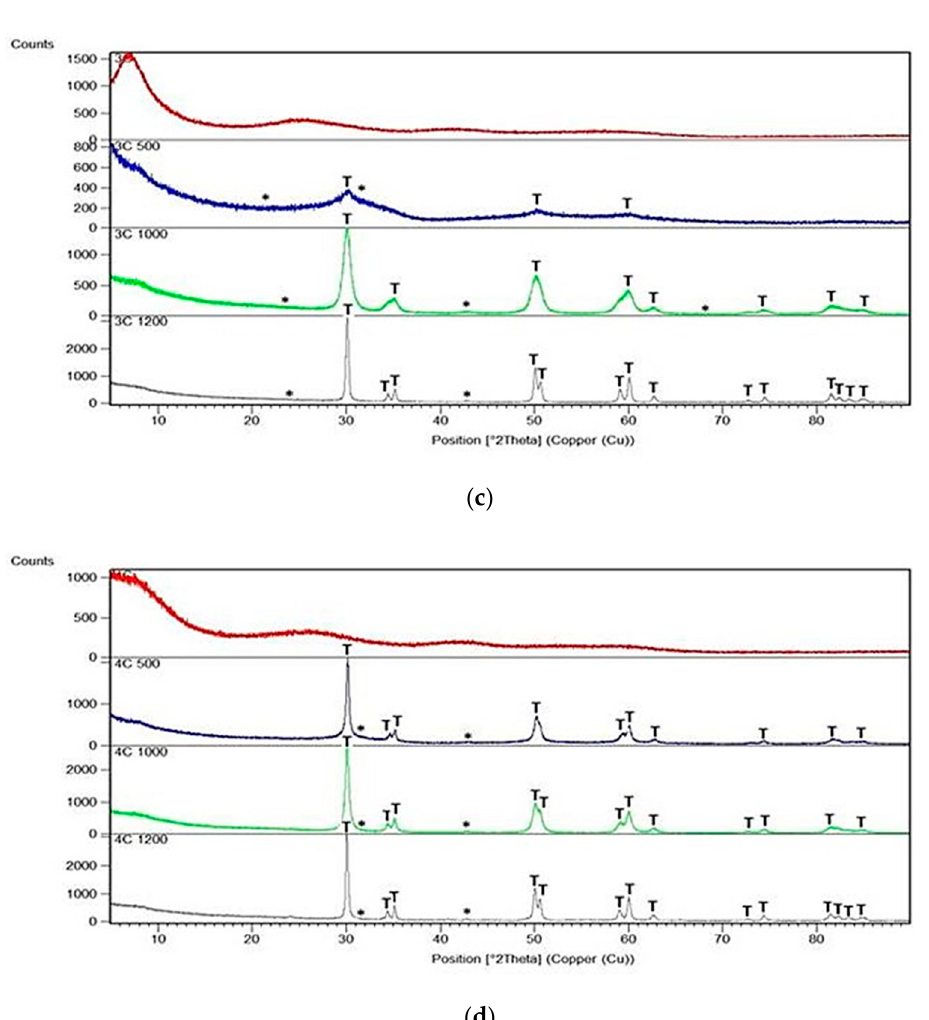
Figure 3. X-Ray diffraction pattern of: ( a ) 1C sample; ( b ) 2C sample; ( c ) 3C sample and ( d ) 4C sample. All samples were synthesized using zirconium (IV) acetate and annealed at 500 °C, 1000 °C and 1200 °C in the air (*—undefined silica, m—monoclinic ZrO 2 , T—tetragonal ZrO 2 , c—cubic ZrO 2 ).